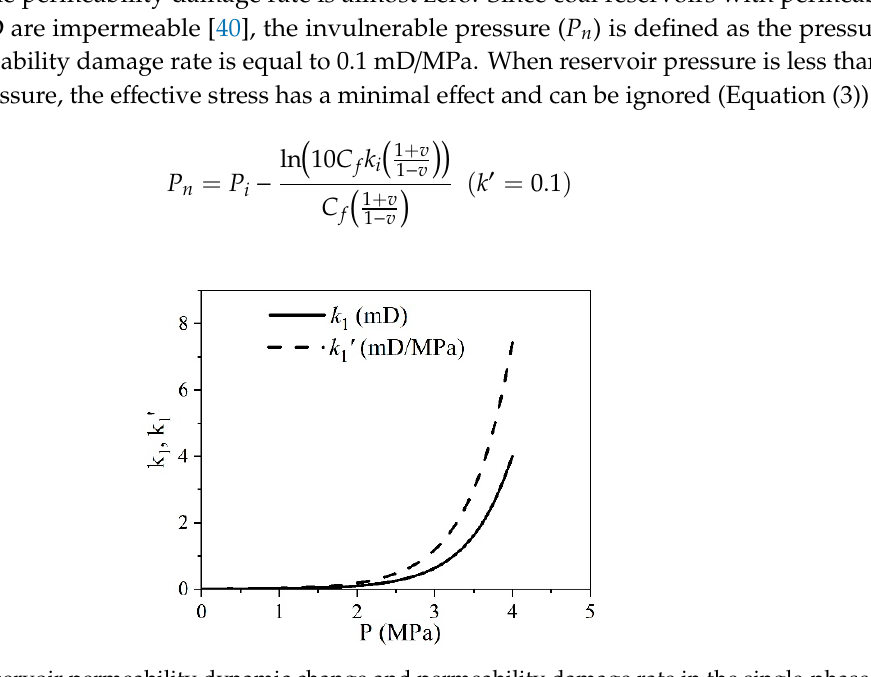
Figure 1. Reservoir permeability dynamic change and permeability damage rate in the single-phase water flow stage.